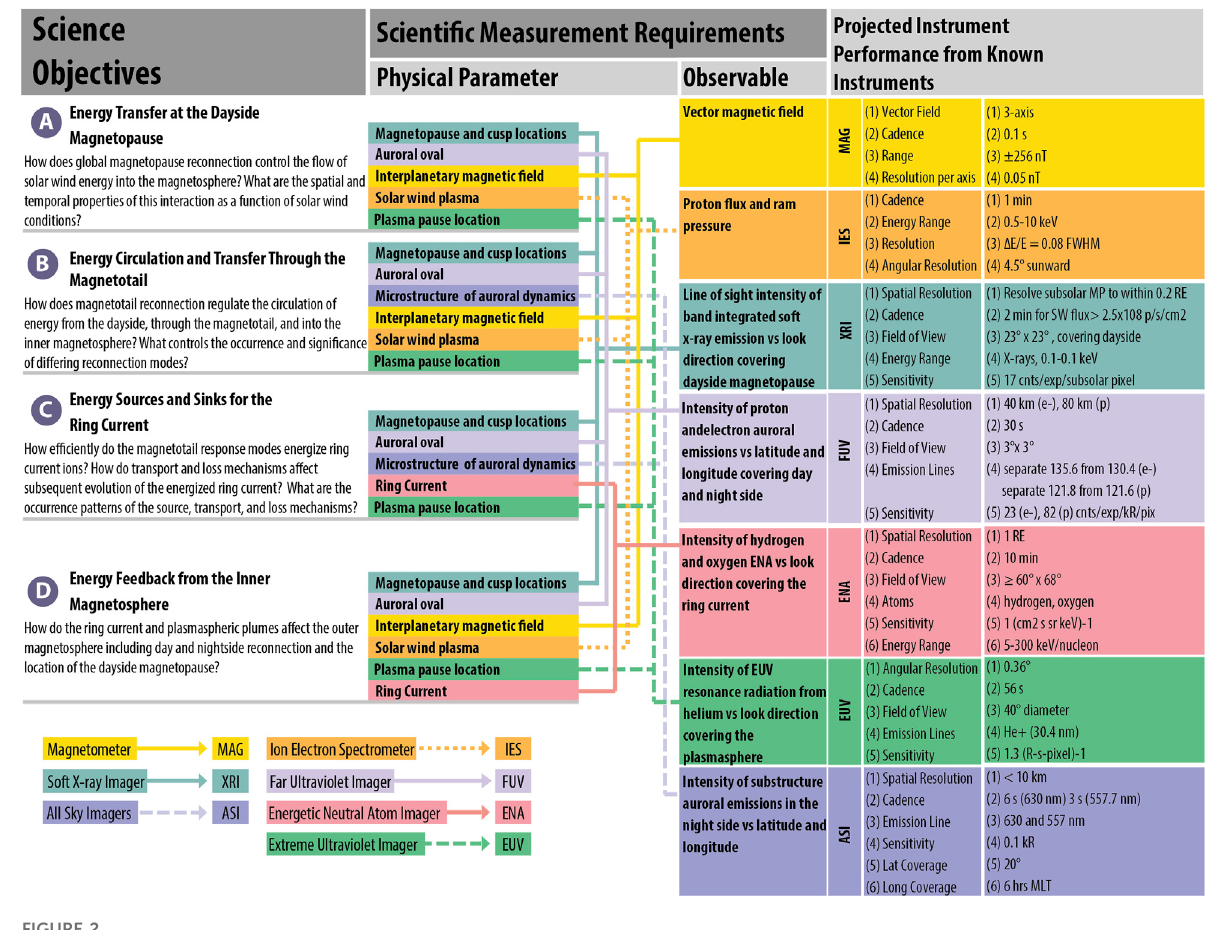
FIGURE 2 A mock science traceability matrix (STM) for the STORM mission. The left shows each objective and the physical parameters in the solar wind and magnetosphere required to be observed in order to address each objective. The right illustrates how each physical parameter maps to a speci fi c observable and instrument. These then map to projected instrument performance which de fi ne the sensitivities, cadences, resolutions, and fi elds-of- view of existing high technology readiness level (TRL)